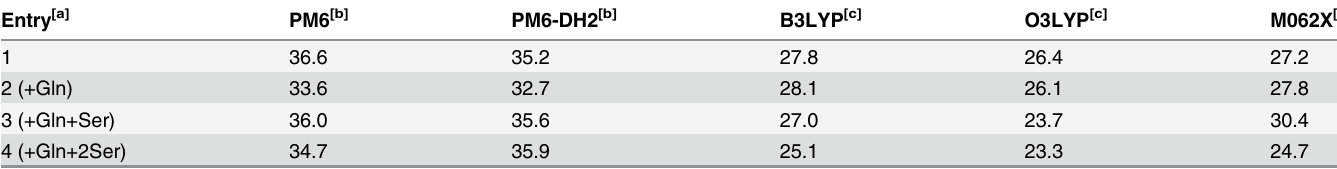
Table 2. Calculated activation barriers of Spinosyn A